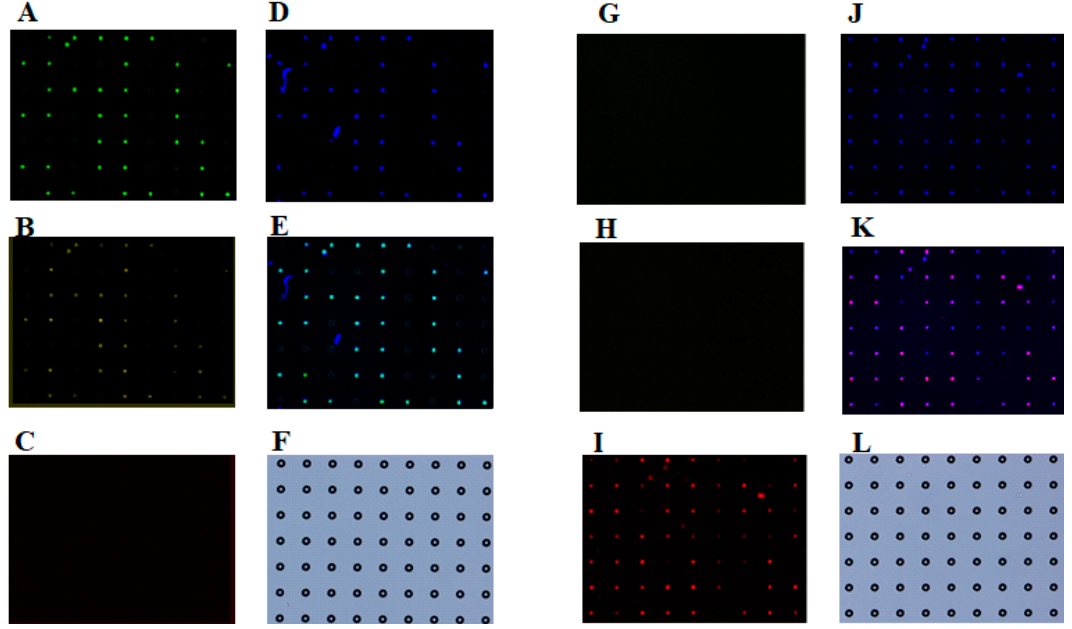
Figure 6. Fluorescence microscopic images of single-cell microarray chip with multi-staining. Fluorescence microscopic images of single ( A – E ) NCI-H1650 and ( G – K ) CCRF-CEM cells on the single-cell microarray chip. NCI-H1650 and CCRF-CEM cells were multi-stained with ( A , G ) PE-labeled anti-cytokeratin, ( B , H ) Alexa Fluor 488-labeled anti-EpCAM, ( C , I ) Alexa Fluor 647-labeled anti-CD45, monoclonal antibodies, and ( D , J ) DAPI. ( E , K ) Merged images. ( F , L ) Light microscopic images of NCI-H1650 and CCRF-CEM.